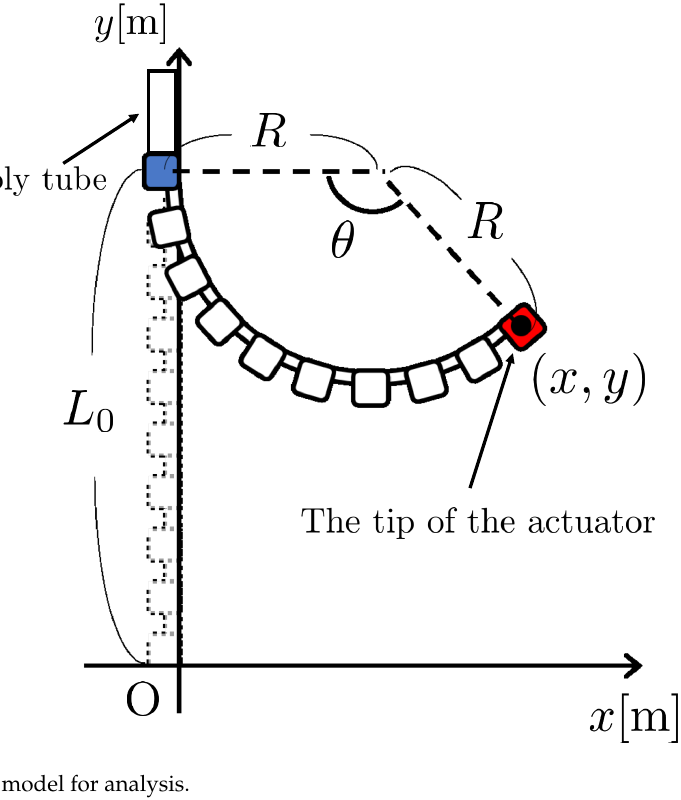
Figure 3. The model for